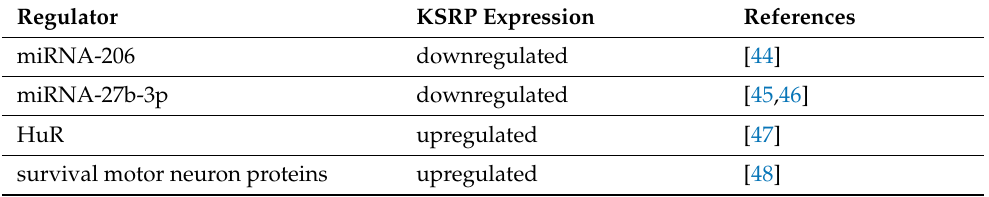
Table 2. Summary of factors that regulate KSRP expression on the post-transcriptional level.